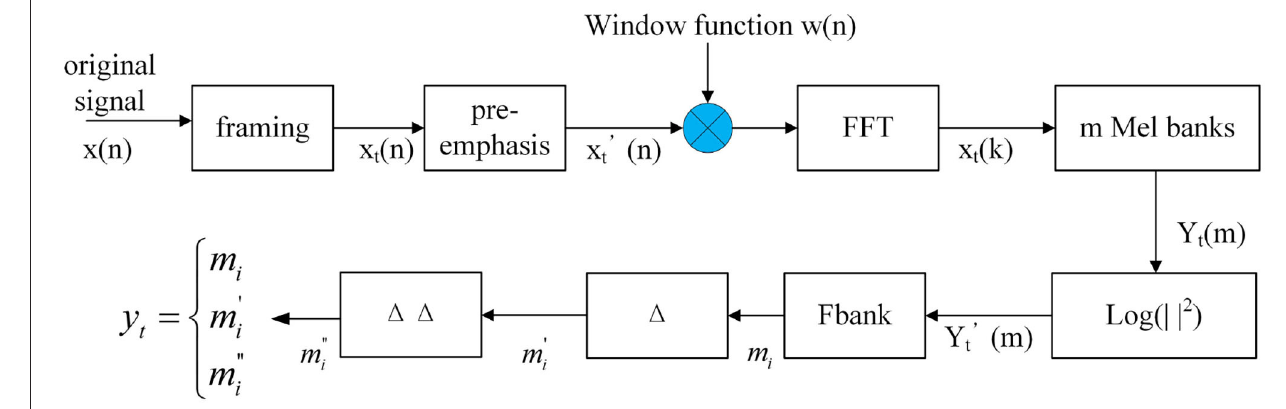
FIGURE 7 | 3D Fbank feature extraction.